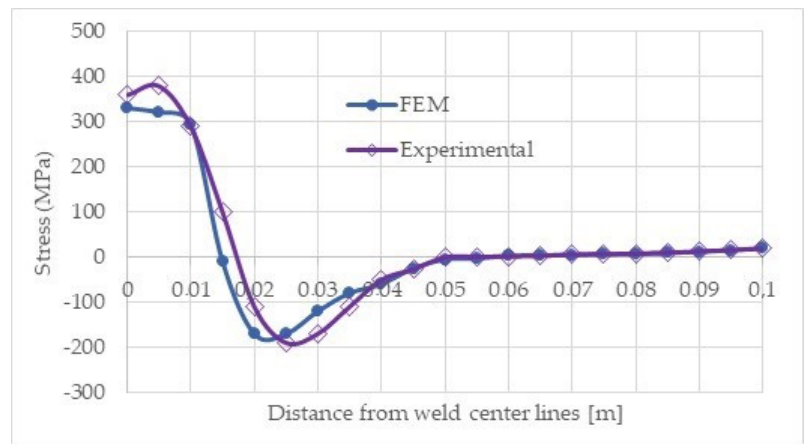
Figure 4. Results from study [38], published at Scientific Technical Review, with permission from the authors Ivana Vasovi´c and Dragi Stamenkovic, 2019.